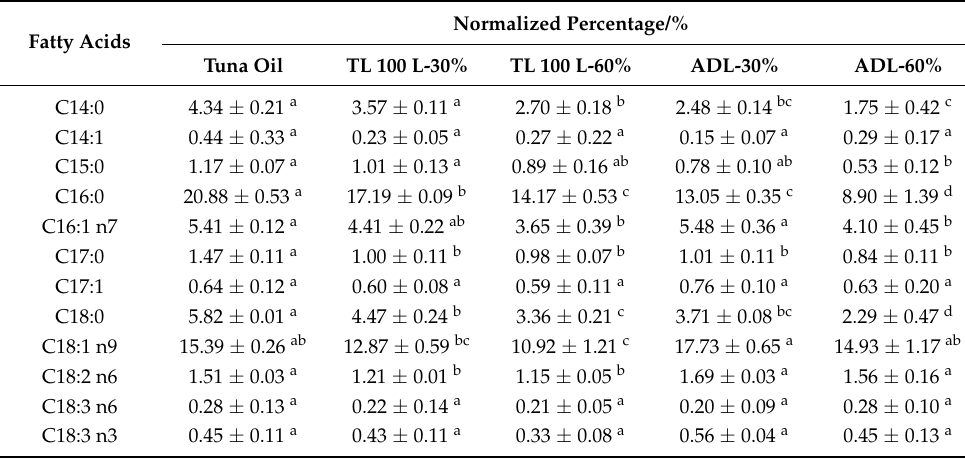
Table 3. Fatty acid composition of tuna oil and its hydrolyzed acylglycerols. Fatty